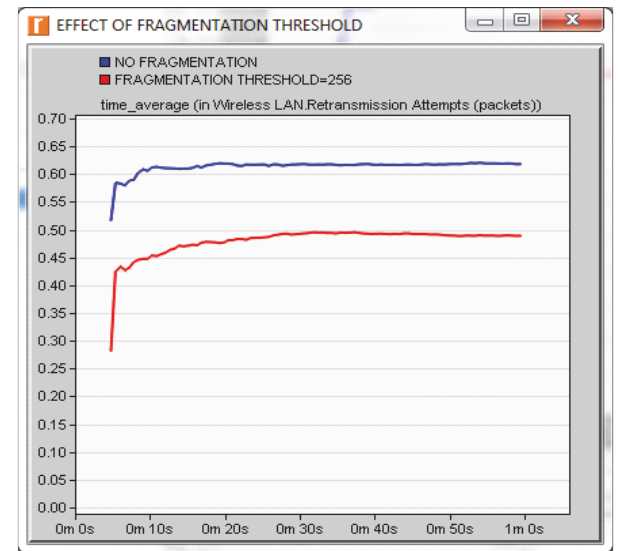
Figure 10: Wireless LAN delay with and without fragmentation.